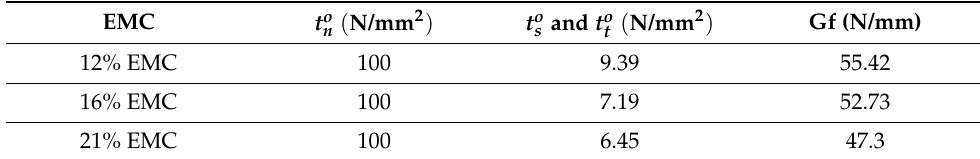
Table 21. 160 × 170 mm CLT damage initiation and evolution